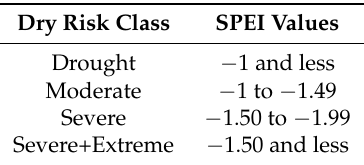
Table 2. Drought classes identified according to different levels of